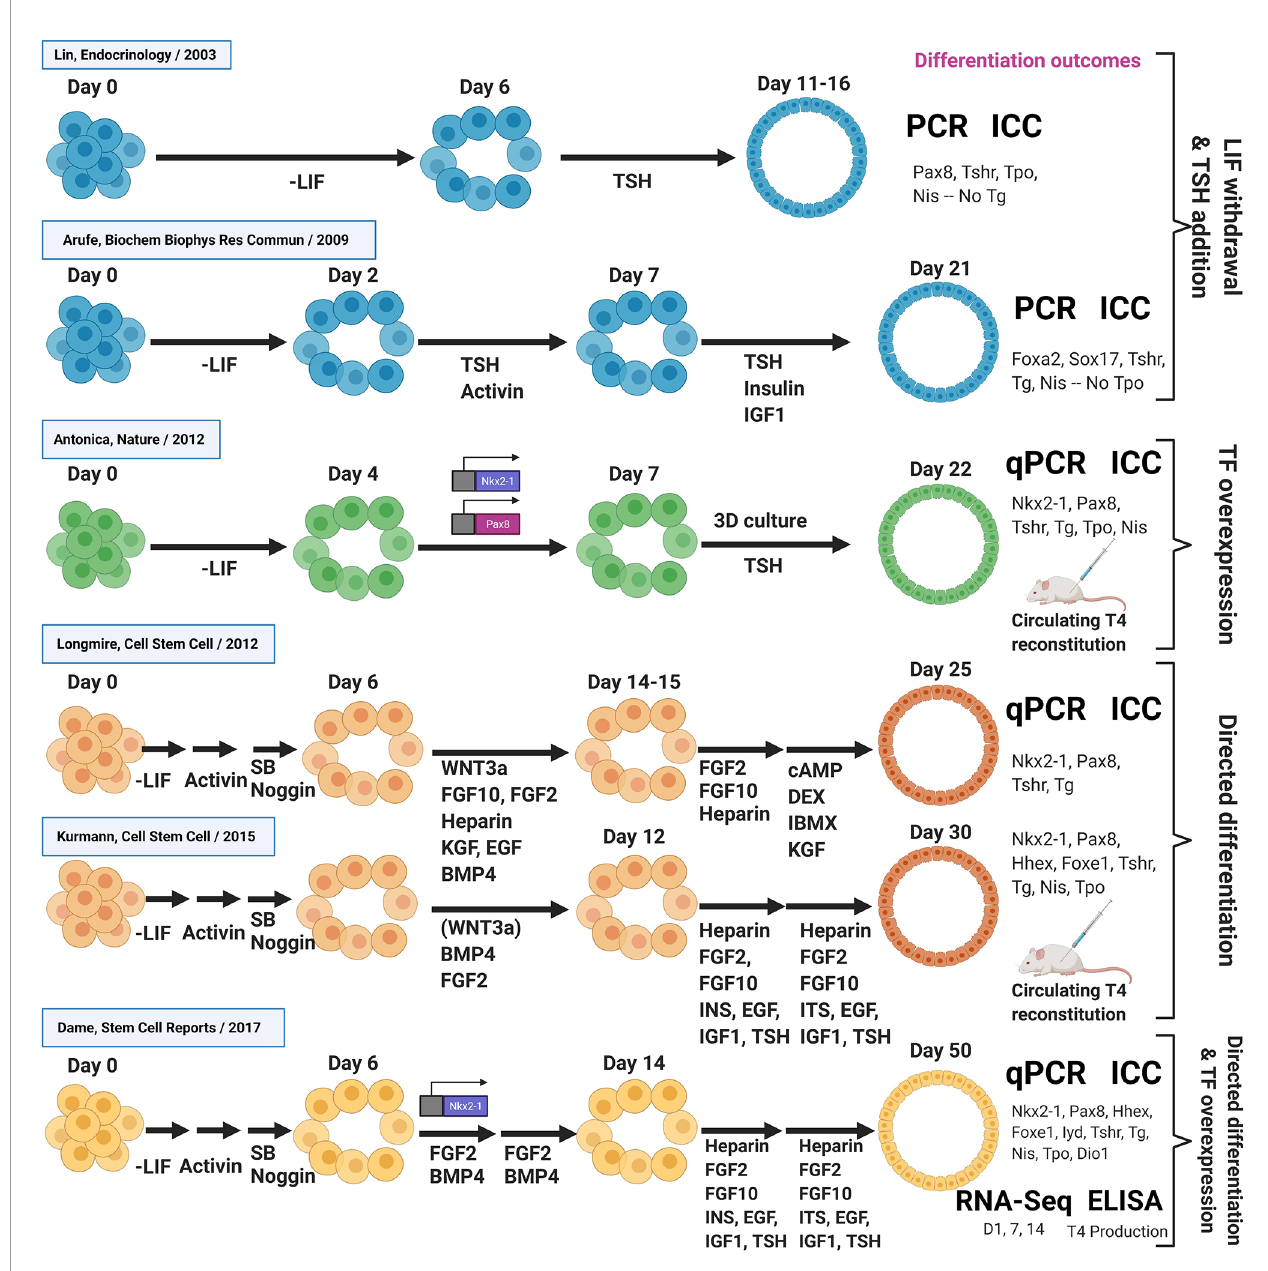
FIGURE 3 | Overview of thyroid differentiation protocols. Overview of published in vitro differentiation approaches to generate thyroid lineage cells from PSCs. Schematic shows key signaling molecules and growth factors, as well as the methods used to quantify differentiation outcomes. In vitro differentiation approaches are sub-divided into early studies involving LIF withdrawal/TSH addition, TF overexpression, directed differentiation approaches, as well as studies combining directed differentiation with TF overexpression. All studies were performed with mouse PSCs, except from the Kurmann et al. paper that also included work with human PSCs. DEX, Dexamethasone; IBMX, 3-isobutyl-1-methylxanthine, a non-speci fi c inhibitor of cAMP and cGMP phosphodiesterases; SB, SB-431542, a chemical inhibitor of the activin receptor-like kinase receptors, ALK5, ALK4 and ALK7 (TGF- b signaling inhibitor); PCR, RT-PCR; qPCR, RT-qPCR; ICC,